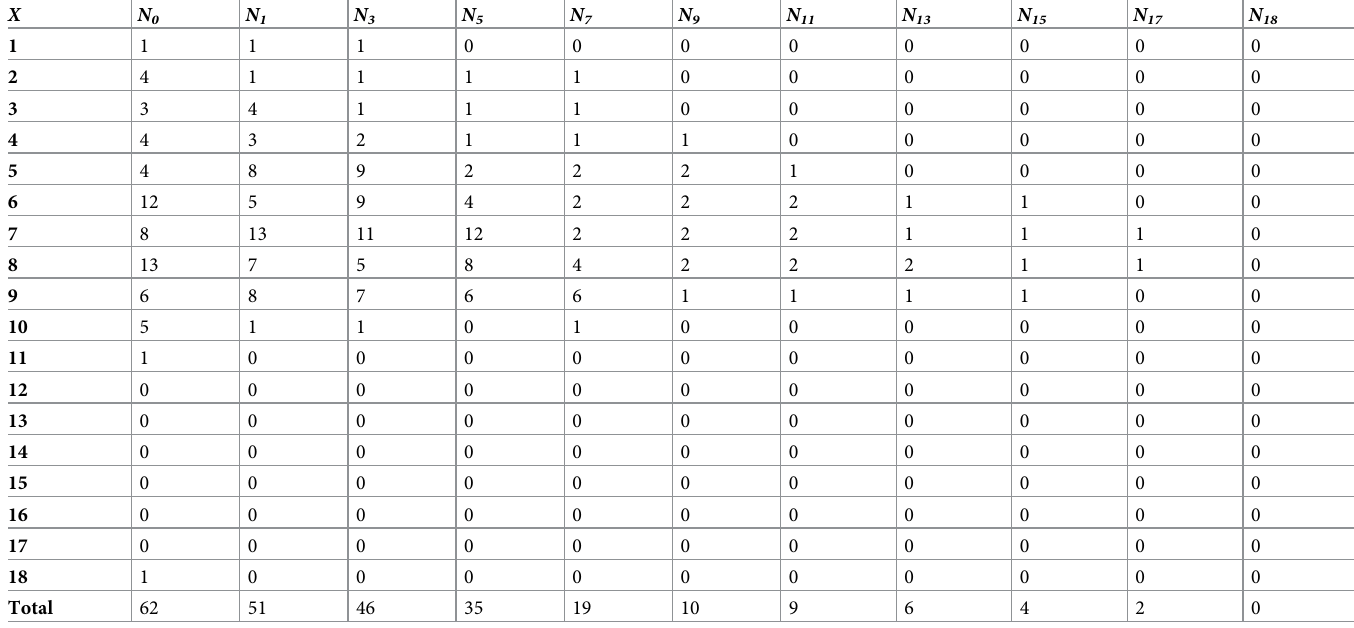
Table 9. Dynamic quantitative prediction model of P . flavus WM population.